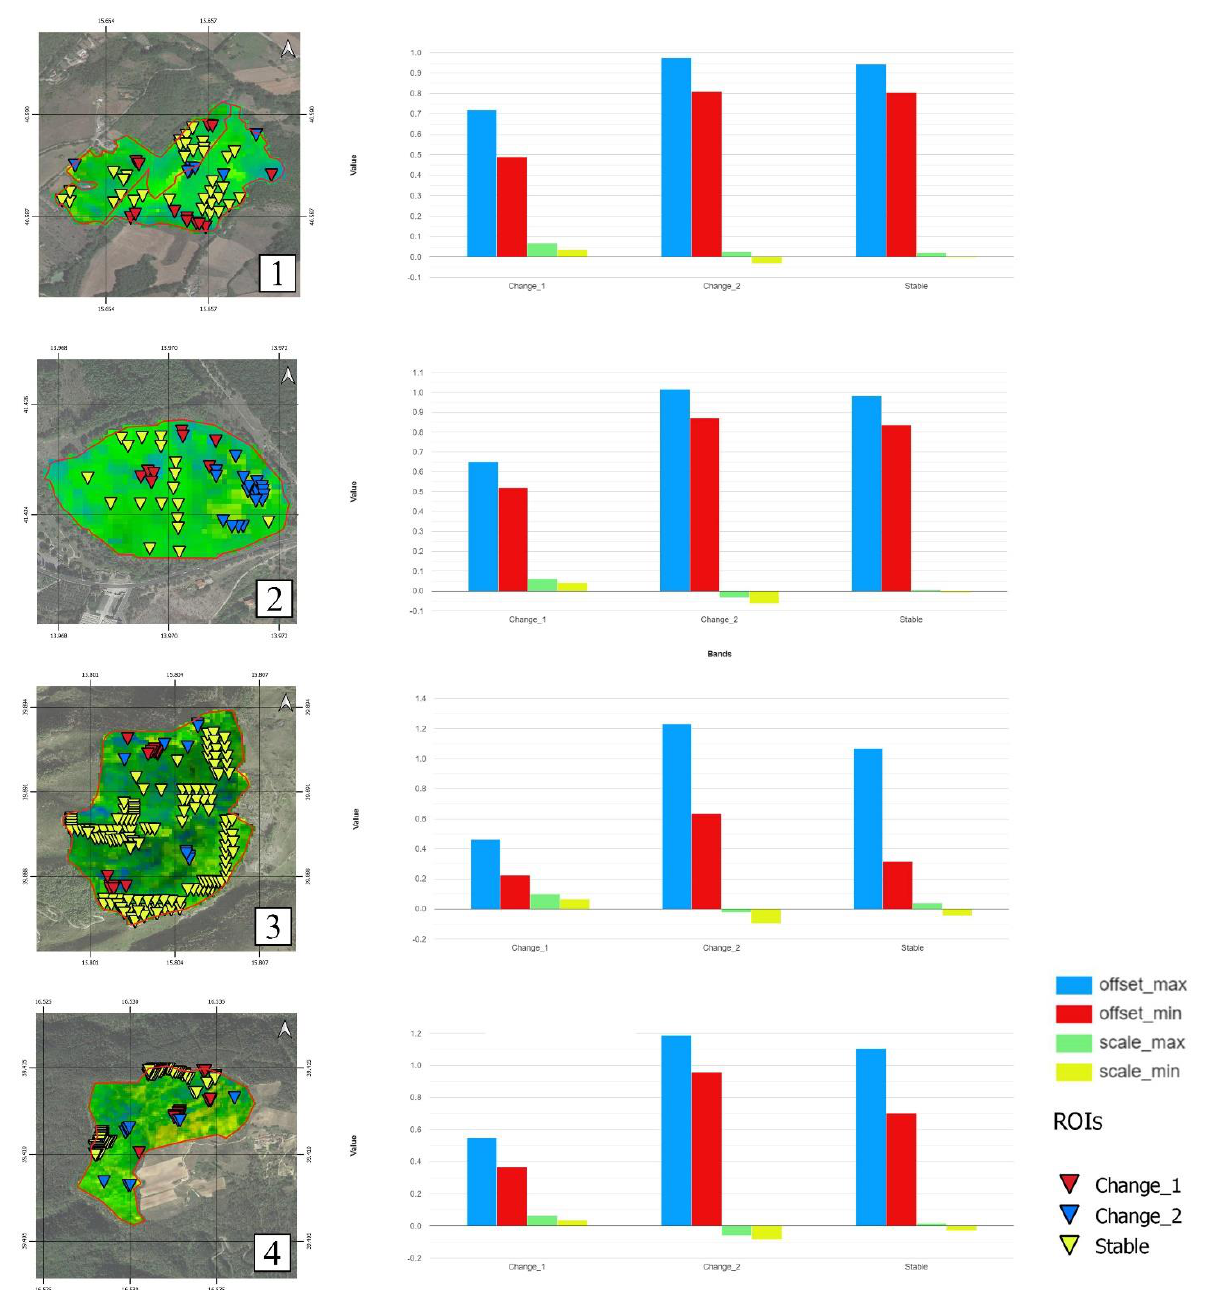
Figure 6. Events 1–4 (referring to IDs in Table 1). Overview image of analyzed cases (RGB: slope, Figure 6. Events 1 – 4 (referring to IDs in Table 1). Overview image of analyzed cases (RGB: slope, offset, slope) and graph of pixel value in selected ROIs. offset, slope) and graph of pixel value in selected ROIs. Second type: tends to yellow in RGB images and black in single-band greyscale images: negative slope (negative trend), due to the decrease in the signal (NDVI value) analyzed over time. The offset values assumed by these pixels were on average higher than those assumed in the pixels of the other two types of behavior observed. Third type: tends to green in RGB images and grey in single-band greyscale images: stable signal over time (stable trend) without changes in the LULC. The offset values